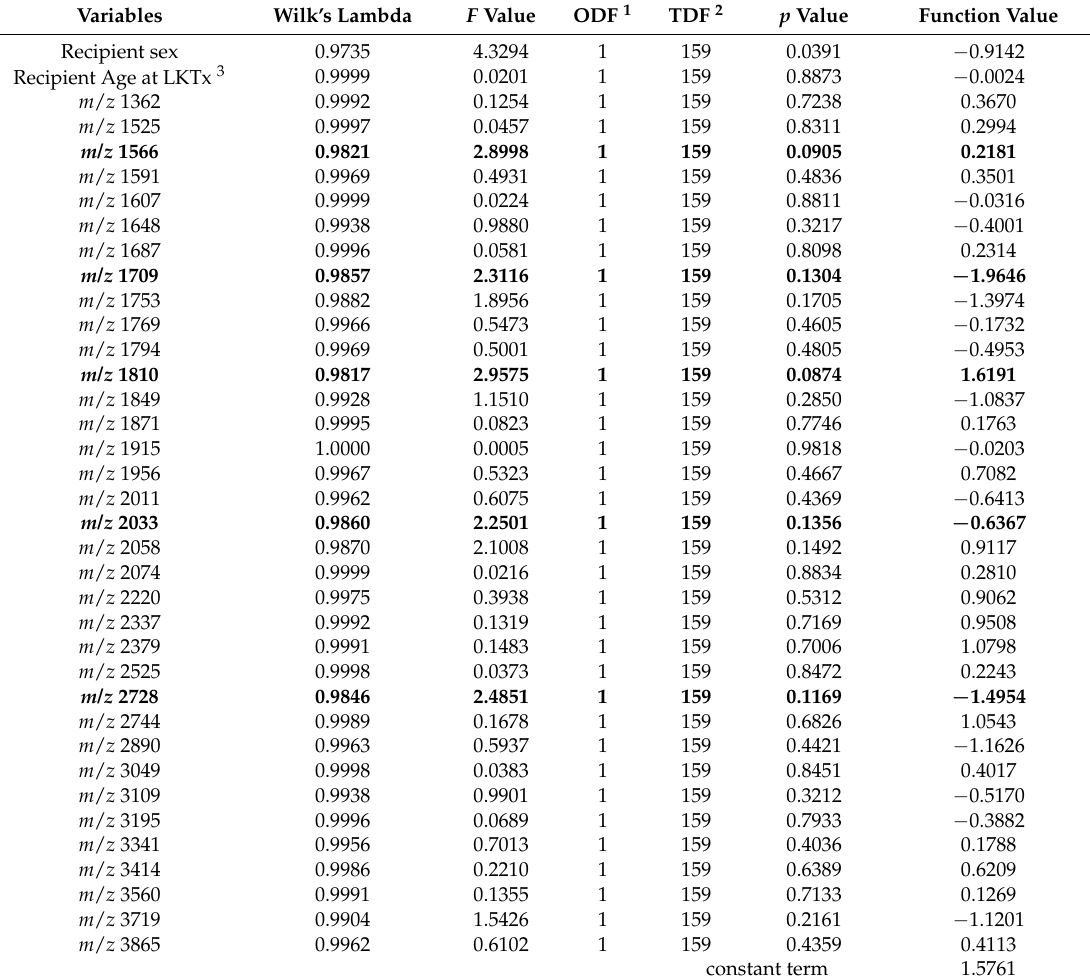
Table 3. Multivariate discriminant analysis for prediction of